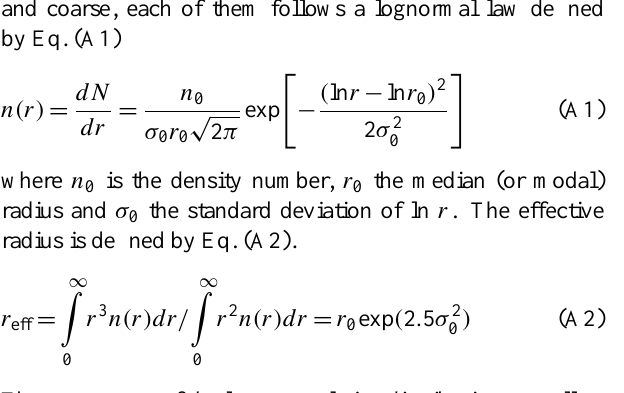
Table A2. Size distribution parameters of the aerosol models over land. m r and m i are the real and imaginary parts of the refractive index. Particles within the coarse mode are not considered in the computations of the